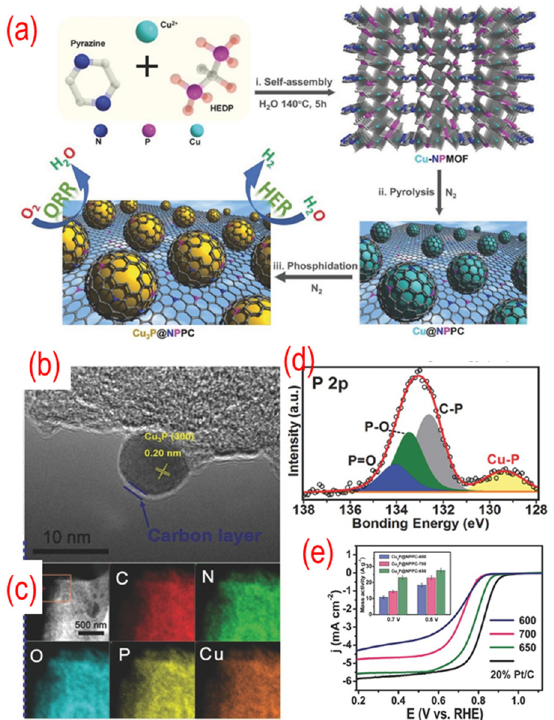
Figure 10. ( a ) The schematic of the synthesis process, ( b ) the TEM image, ( c ) C-, N-, O-, P-, and Cu-elemental mappings, ( d ) the high-resolution P 2p peaks, ( e ) the activity test (LSV curves recorded by RDE in O 2 -saturated 0.1 M KOH solution with 1600 rpm at a scanning rate of 10 mV s − 1 ), of Cu 3 P@ P, N-graphene. The inset of ( e ) is the mass activity of Cu 3 P@ P, N-graphene catalysts. Reproduced with permission from [107]. © 2022 Wiley-VCH Verlag GmbH & Co. KGaA, Weinheim.